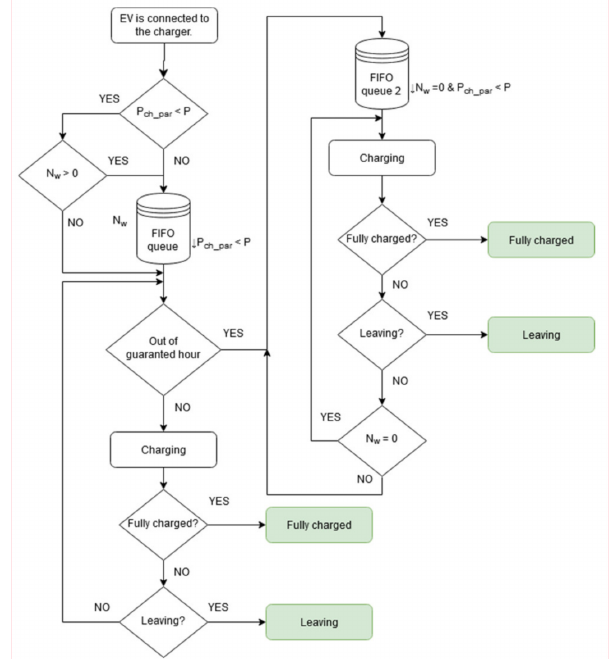
Figure 3. Resident charging